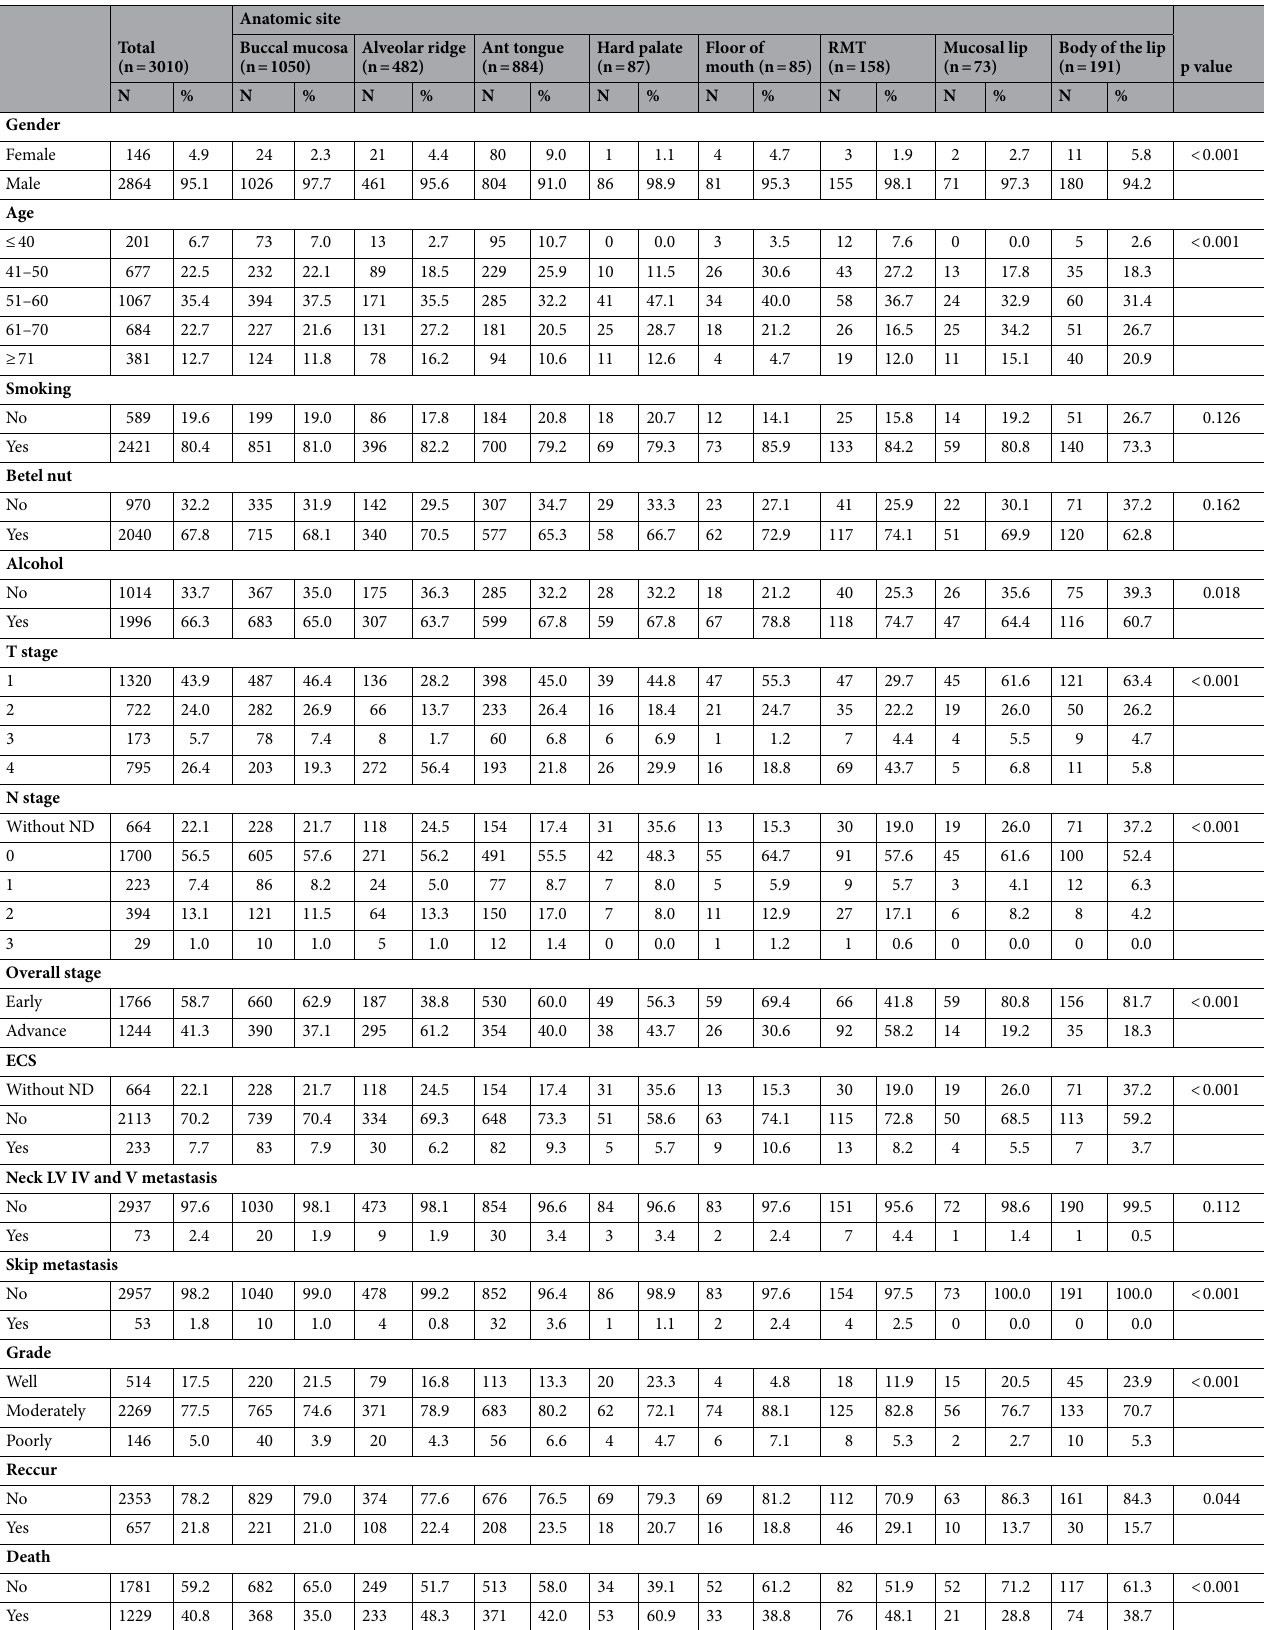
Table 1. The clinicopathological characteristics of cases by anatomic location. ND neck dissection, RMT retromolar trigone, ECS extra-nodal